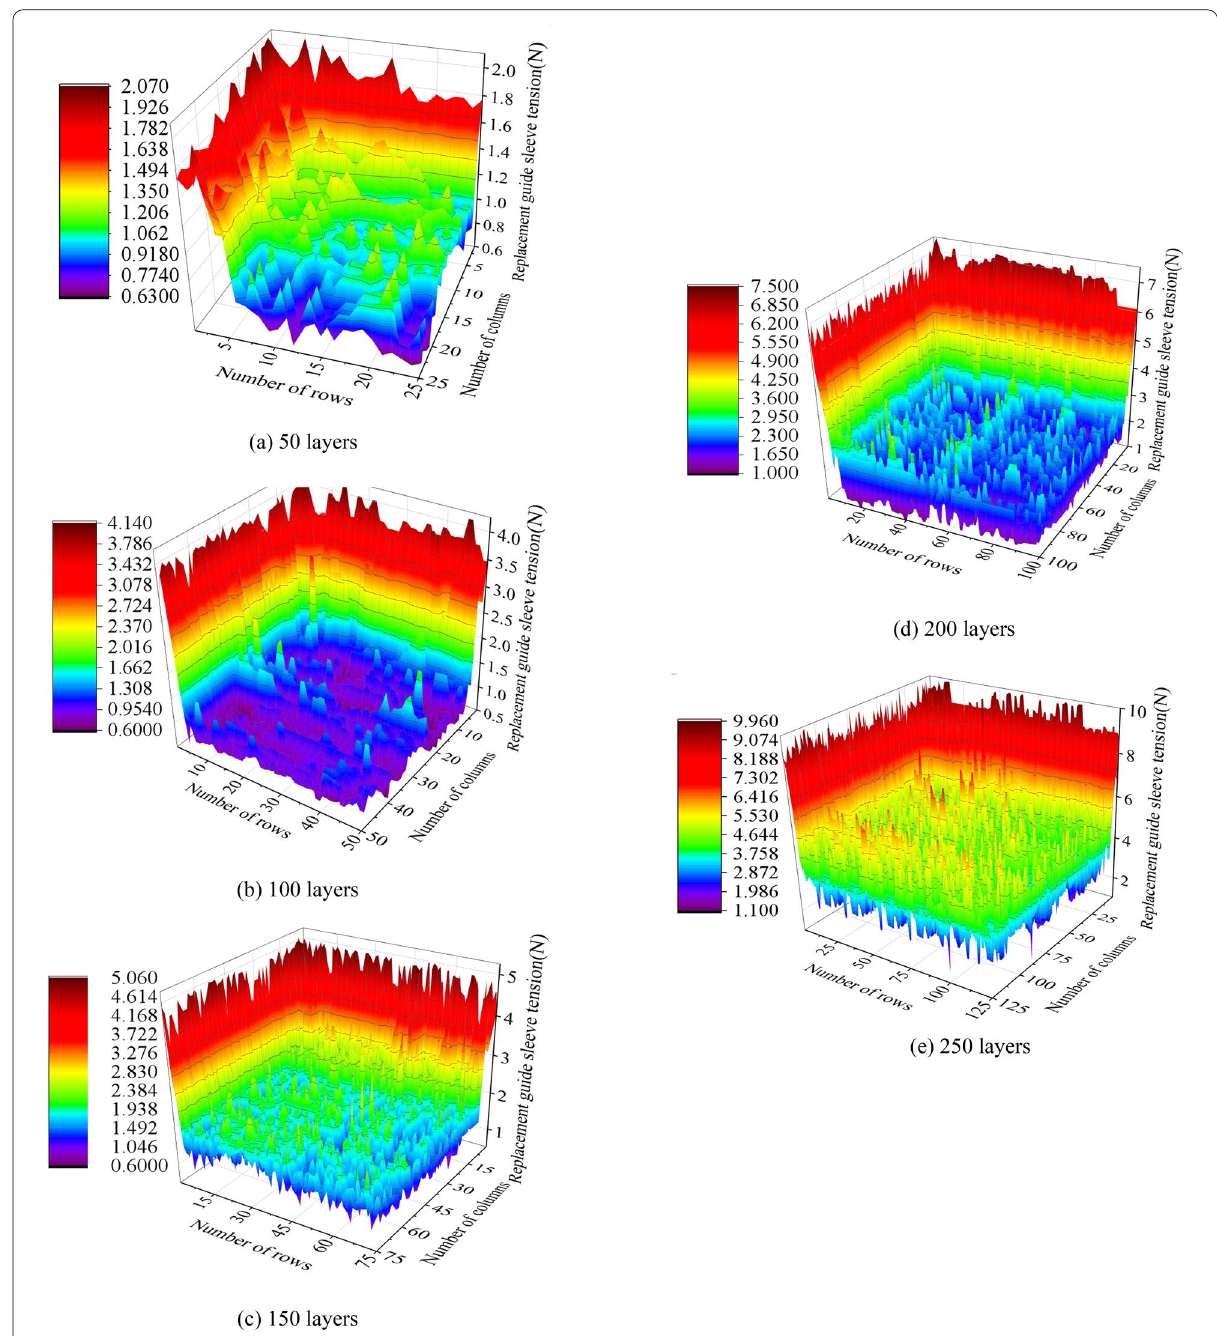
Figure 7 Yarn replacement force